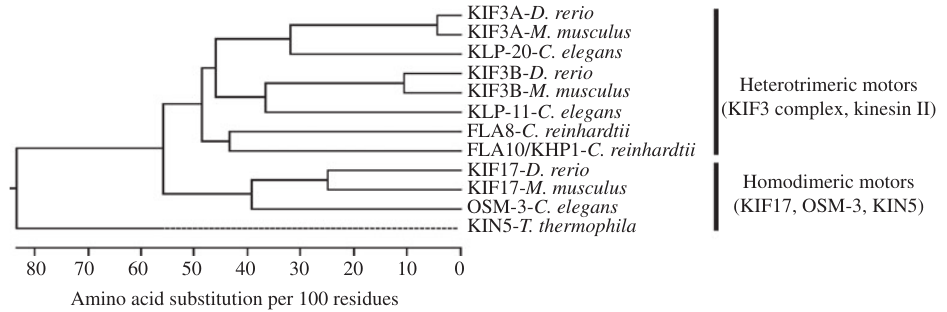
Figure 1 Phylogenetic tree showing the relationship of kinesin 2 family heavy chains discussed in this review. The tree was constructed with the Clustal W method of multi-sequence alignment using DNASTAR software. A more complete analysis of all kinesin heavy chains including the kinesin 2 family can be seen in (6) and the associated website. The tree shows evolutionary distance mea- sured as substitutions per 100 amino acids using the full-length sequences of each heavy chain. Included are the heterotrimeric heavy chains KIF3A and KIF3B from Danio rerio and Mus musculus . The comparable heavy chains, KLP-20 and KLP-11, from Caenorhabditis elegans , and FLA10/KHP1 and FLA8 from Chlamydomonas reinhardtii are included as well. FLA8 is the heavy chain binding partner of FLA10 (58) . The homodimeric heavy chains include KIF17 from D. rerio and M. musculus , OSM-3 from C. elegans , and KIN5 from Tetrahymena thermo- phila . The dashed line associated with KIN5 represents a negative branch length caused by averaging during the alignment. A homodimeric kinesin 2 motor has not been described in C. reinhardtii